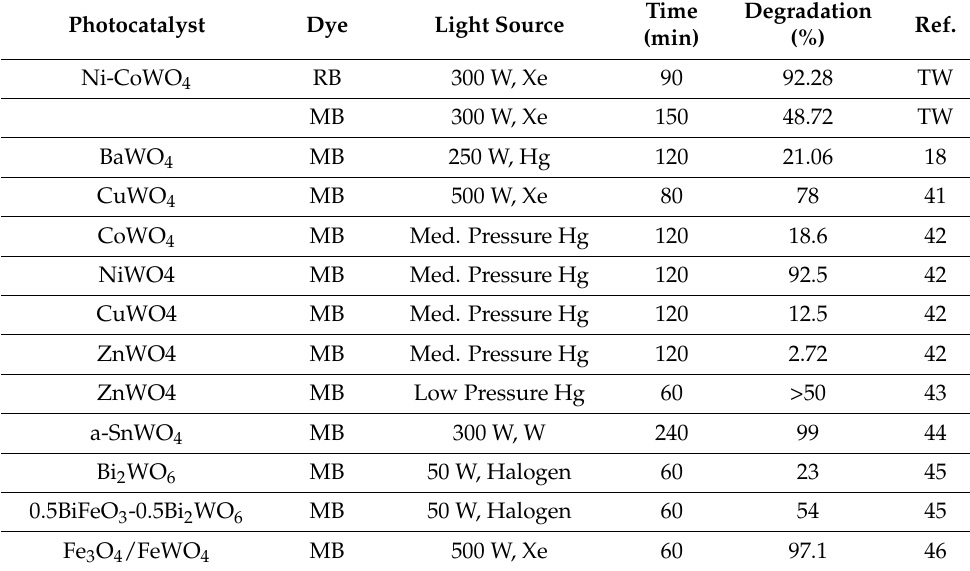
Table 3. Comparison of the photocatalytic activity of Ni-CoWO 4 with other